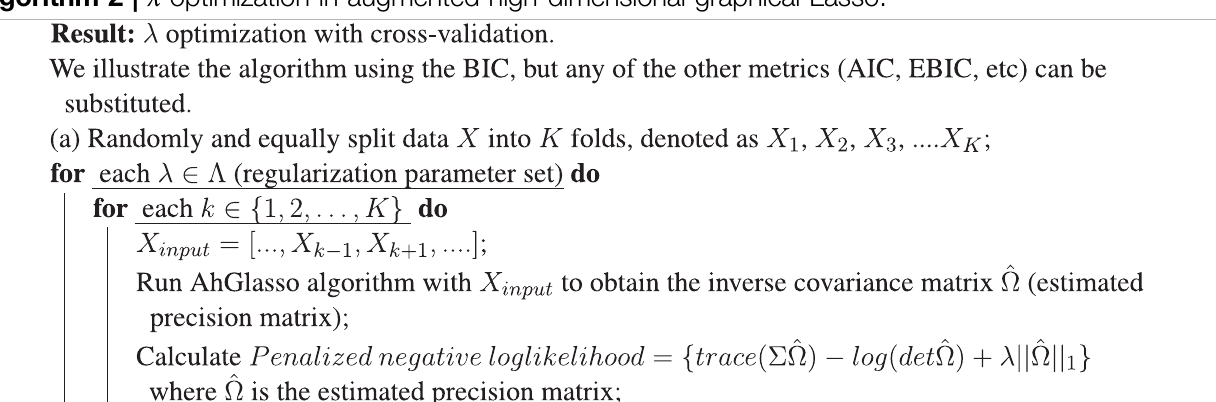
Algorithm 2 | λ optimization in augmented high-dimensional graphical